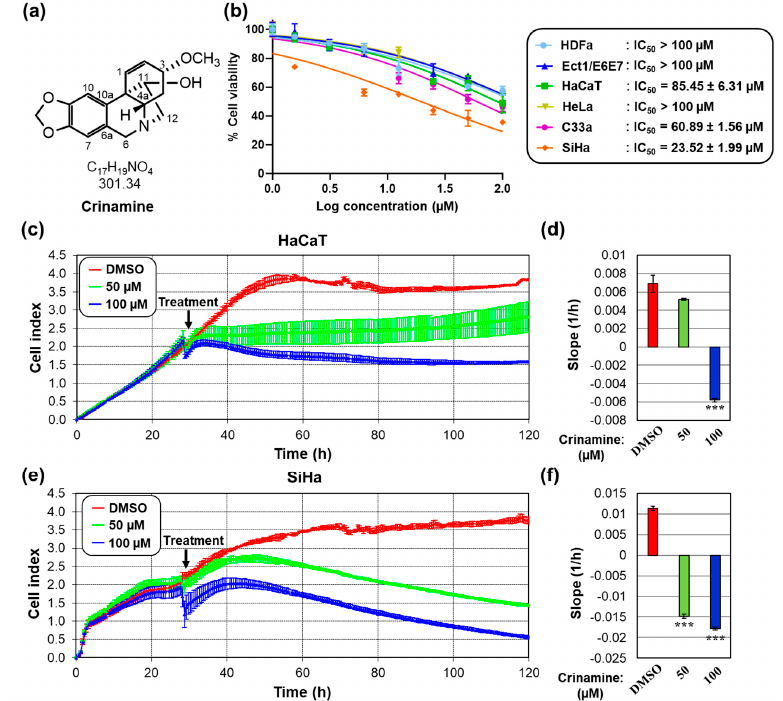
Figure 1. Selective cytotoxicity of crinamine against cervical cancer cell lines. ( a ) Structure of crinamine isolated from C. asiaticum var. asiaticum as determined by spectroscopic data. ( b ) Inhibitory dose-response curves of HDFa, Ect1/E6E7, HaCaT, HeLa, C33a, and SiHa cells treated for two days with crinamine. Cell viability was determined and normalized to DMSO. IC 50 values were calculated from triplicates obtained from two independent experiments and are represented as the mean ± standard deviation (SD). ( c – f ) Real-time proliferation of ( c,d ) HaCaT and ( e,f ) SiHa cells following treatment with crinamine. Cells grown in E-plates were incubated with DMSO or the indicated concentrations of crinamine when the cell index was approximately 2.0. ( c,e ) The rates of cell proliferation were continuously monitored for four days after treatment. ( d,f ) The slope was calculated between 30 and 120 h time points and is reported as mean ± SD from duplicate measurements. Results presented here are typical of data observed on two separate occasions. *** p < 0.001 vs. control.